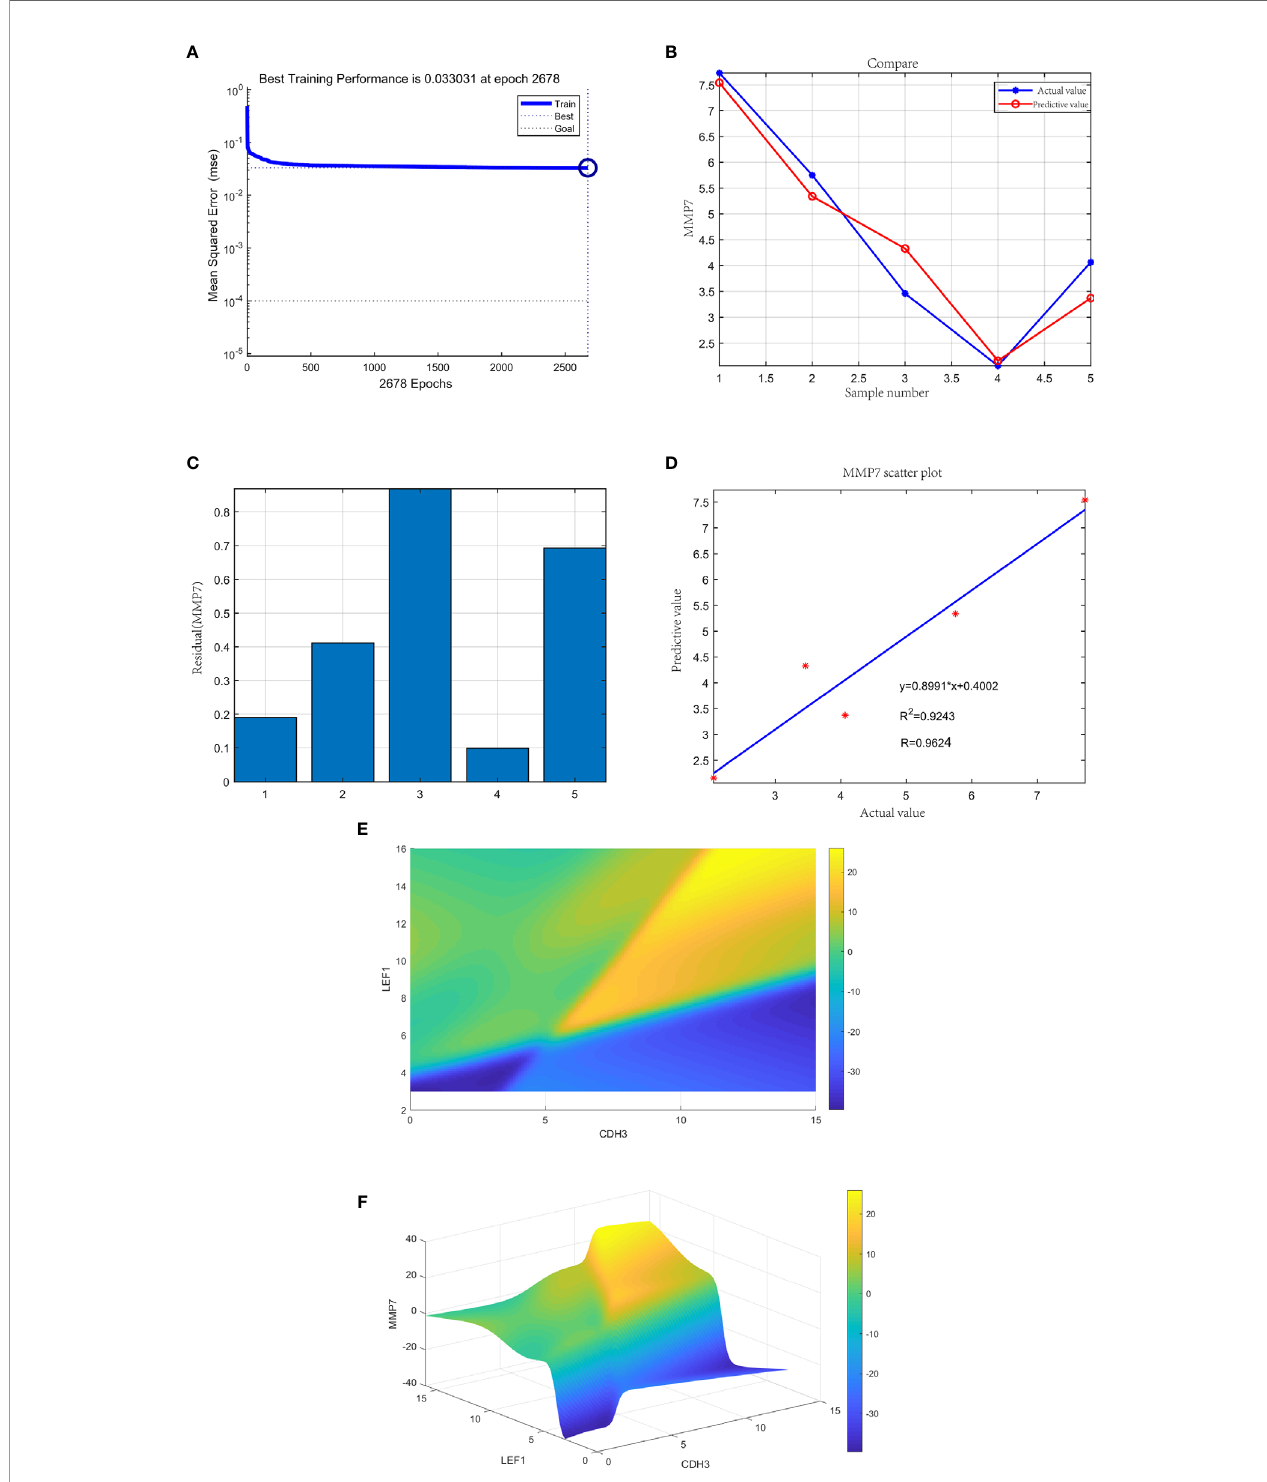
FIGURE 14 | (A) The neural network prediction model of gastric cancer. The best training performance was 0.033031 at epoch 2678. (B) The predicted value of the data was veri fi ed against the actual value. (C) Residual plot of difference between actual and predicted values. (D) The fi nal training model of neural network prediction model, and the relativity was 0.9624. (E) The high-risk warning range of gastric cancer at the level of the planform. (F) The high-risk warning range of gastric cancer at the level of the three-dimensional stereogram. The color represents MMP7 expression: “ yellow ” represents “ high ” and “ blue ” represents “ low ”